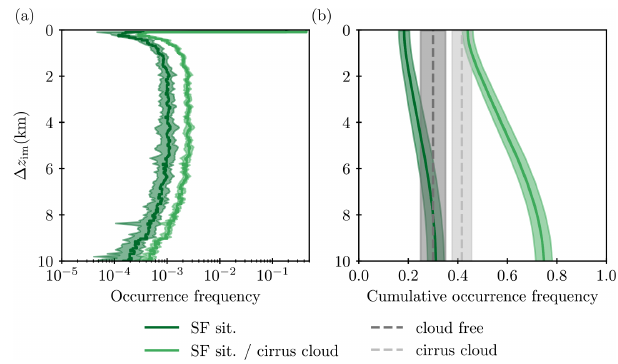
Figure 3. (a) Occurrence frequency of seeder–feeder situations (SF sit.) with respective (cid:49)z im as a fraction of measurements (dark green) or cirrus cloud measurements (light green). (b) Cumulative occurrence frequency. For (cid:49)z im , a vertical resolution of 60m is used. For comparison, the fractions of measurements with at least one cirrus cloud (light grey) and with a cloud-free atmosphere (dark grey) are given. Here and in the following, data from all tracks in the study time (2006 to 2017) and within the study domain were used (2210 satellite tracks). The total number of measurements is 853833, with 267354 measuring (cid:49)z im and 355331 measuring cir- rus clouds. The shaded areas visualize the standard deviation of interannual variability. Note that (cid:49)z im = 0m is at the base of the lowest cirrus cloud layer with T < − 35 ◦